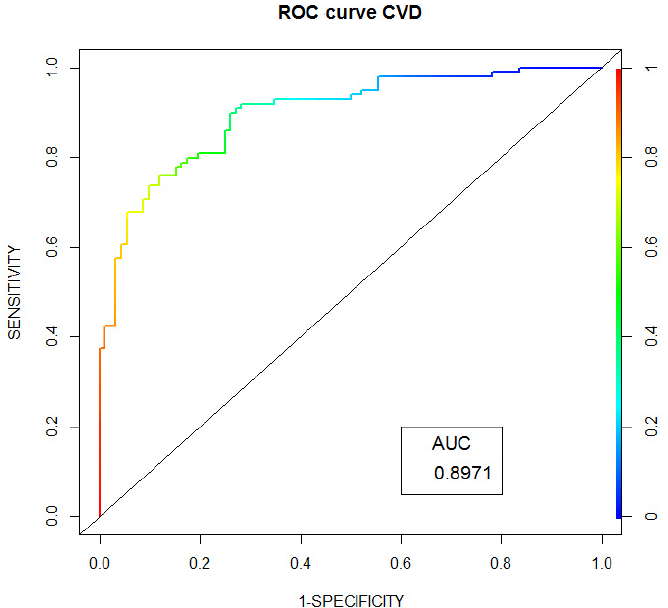
Figure 1. ROC curve in the prognostic model of the coronary heart disease (CHD) outcome when taking into account the index “cum LDL-C” in FH